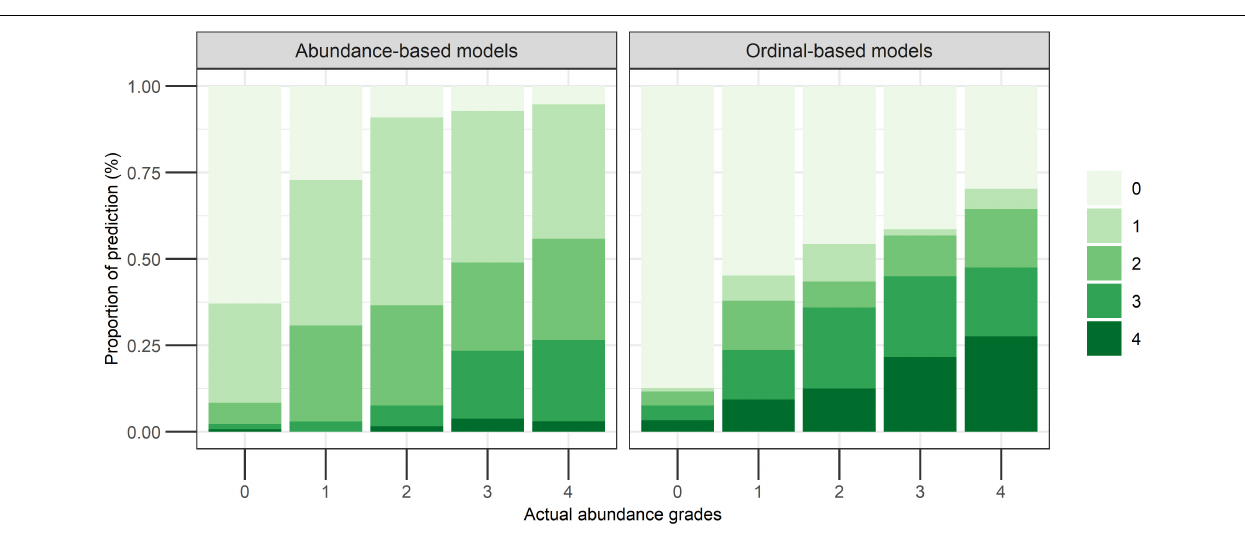
FIGURE 4 | The ordinal categorical predictions of L. litulon from the models using two data